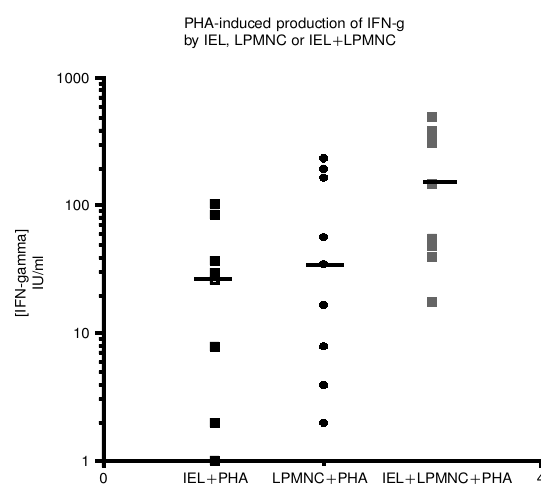
FIG. 3. Interferon-gamma concentration (IU ml) secreted by mucosal lymphocytes. IFN-gamma secretion by LPMNC is signi® cantly increased by the addition of IEL.